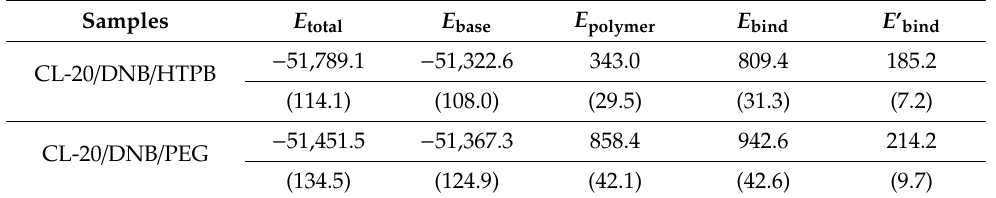
Table 6. Total energies, component energies, binding energy and its normalized values of two di ff erent